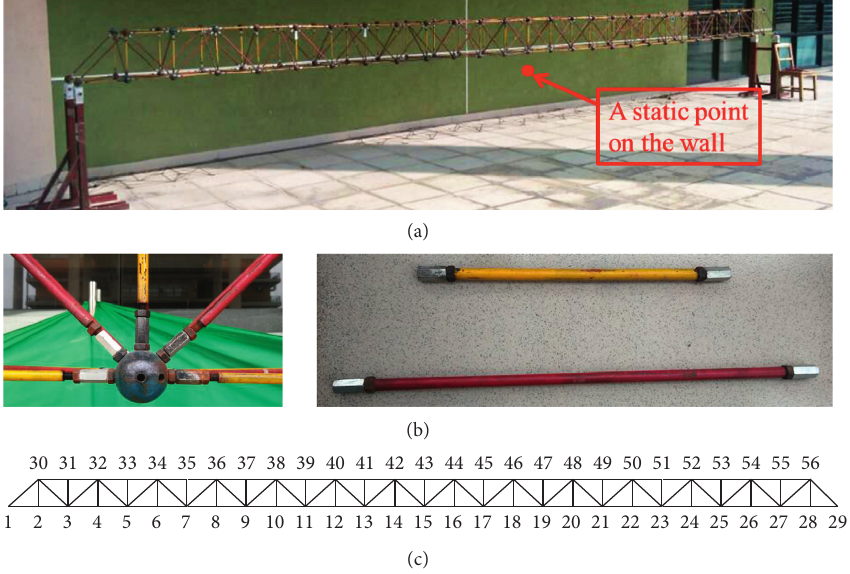
Figure 3: Experimental setup for modal analyses and the bridge model. (a) Bridge model. (b) Model components. (c) Node